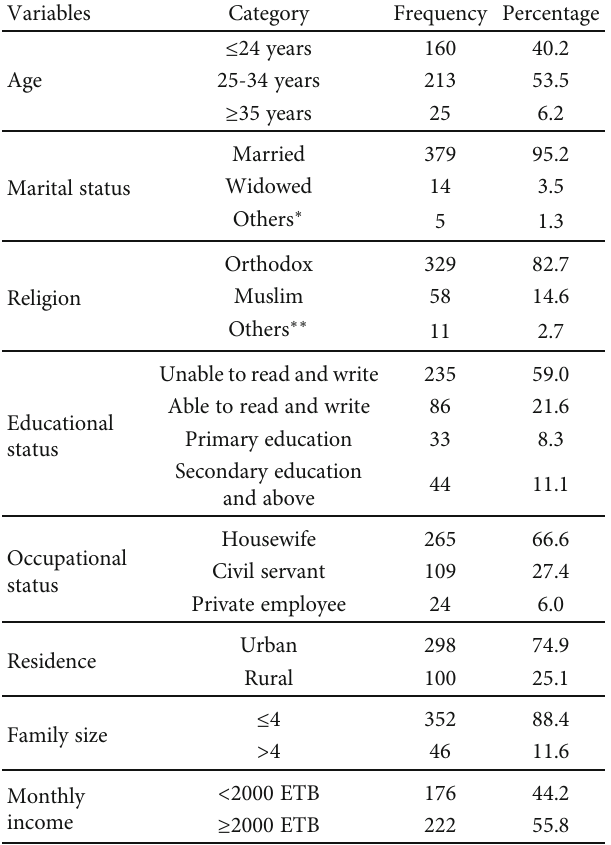
Table 2: Obstetric characteristic of mothers who gave birth at a public hospital in North Wollo Zone, Northeast Ethiopia, 2019 ( n = 398